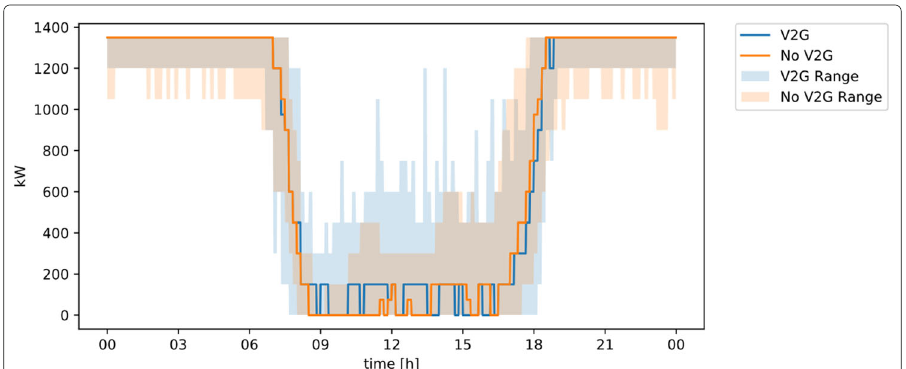
Fig. 5 Power Profile with V2G Enabled. Solid line — median; fill — range